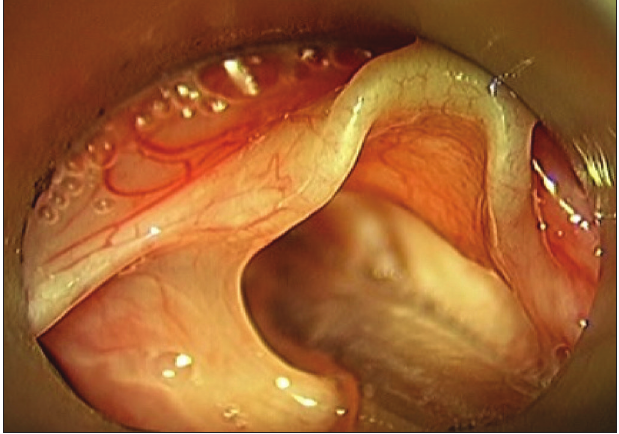
Figure 1. Intraoperative aspect of a 3 - month old child with laryngo- malacia, detail of the aryepiglottic fold shortening.